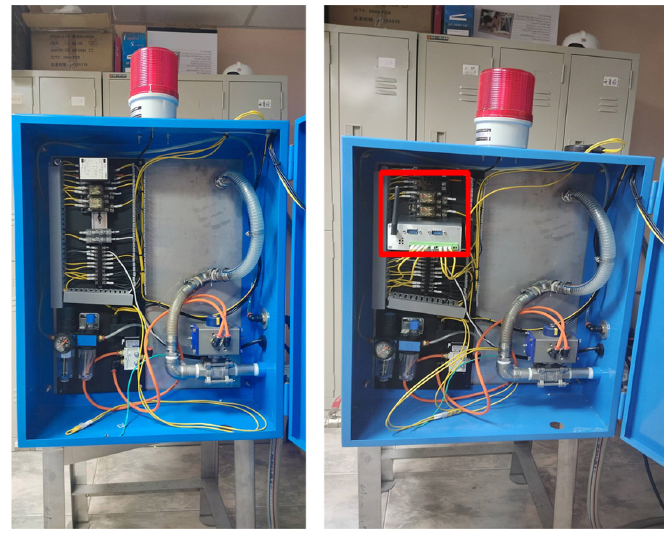
Figure 4. Oil–water mixing machine equipment.